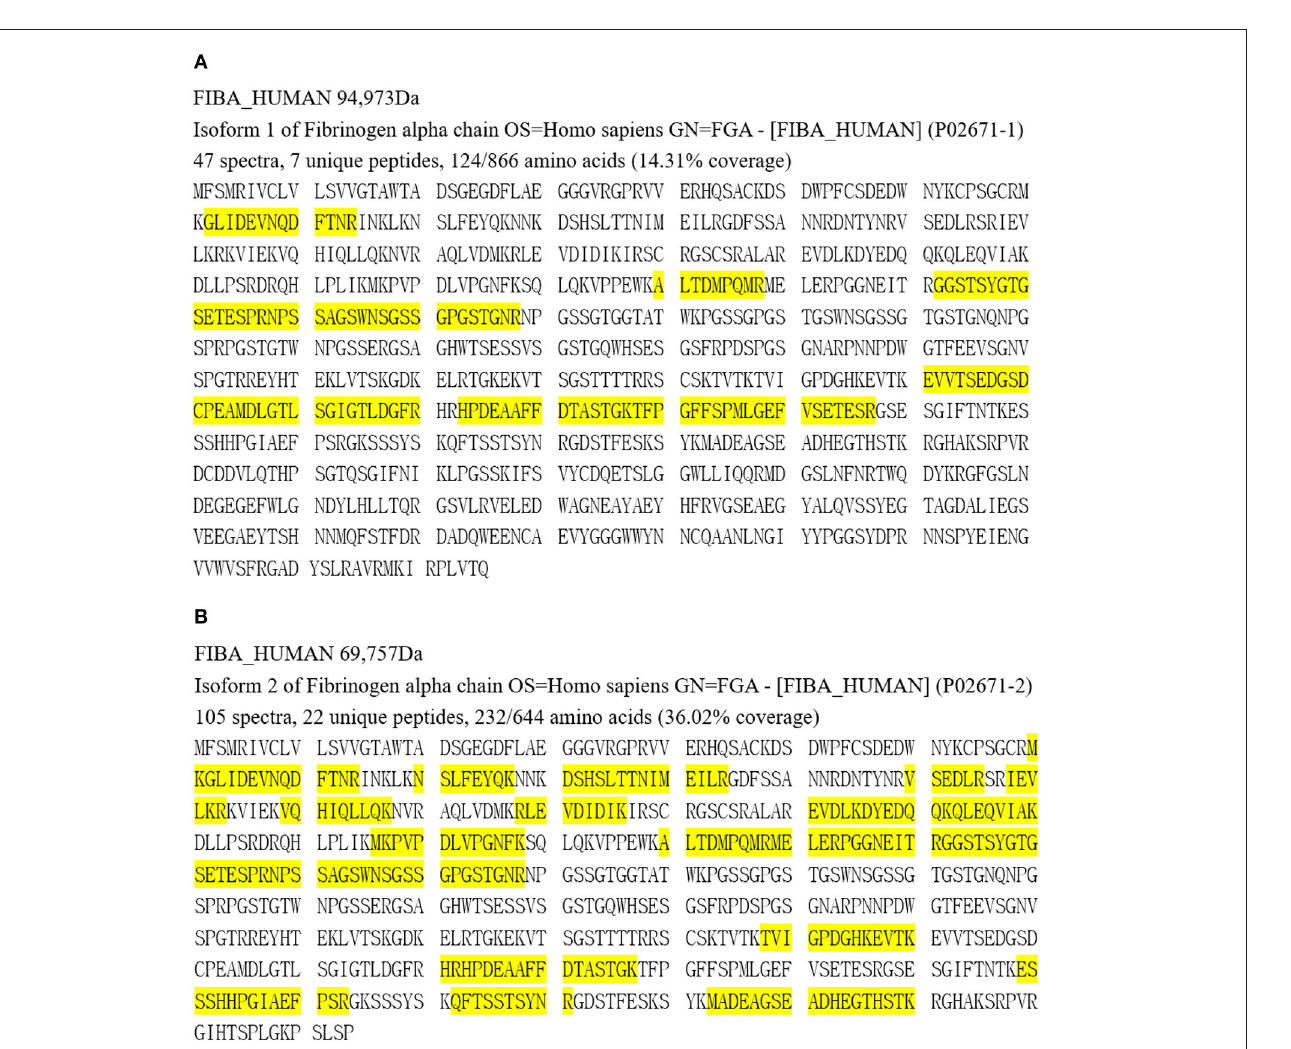
FIGURE 4 | Proteomic analysis results of Patient 1 (A) and Patient 2 (B) . Yellow part represents covered amino